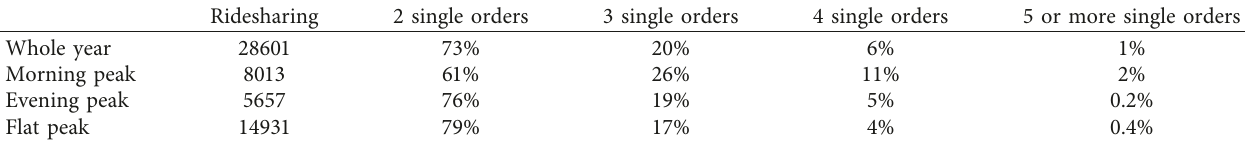
Figure 14: “door-to-door” operation of traditional bus mode and shared bus mode. Table 4: Ridesharing order and composition analysis.